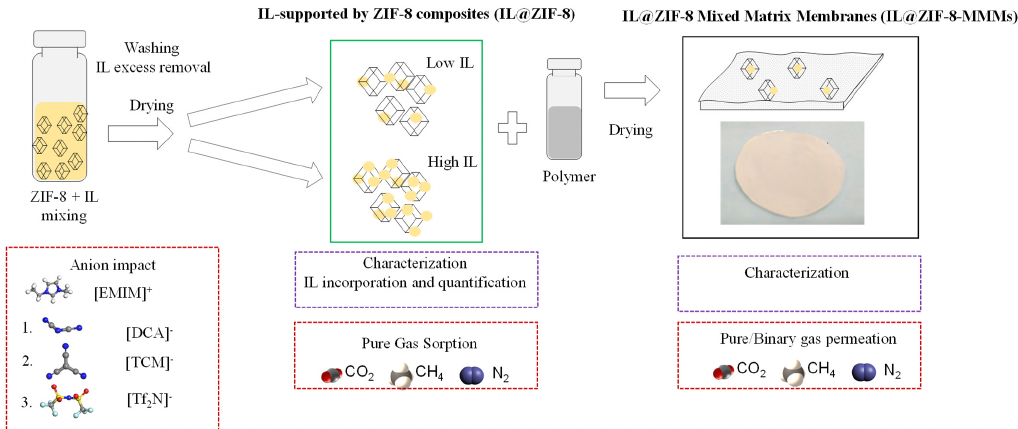
Figure 1. Scheme of the methodology followed in this study.